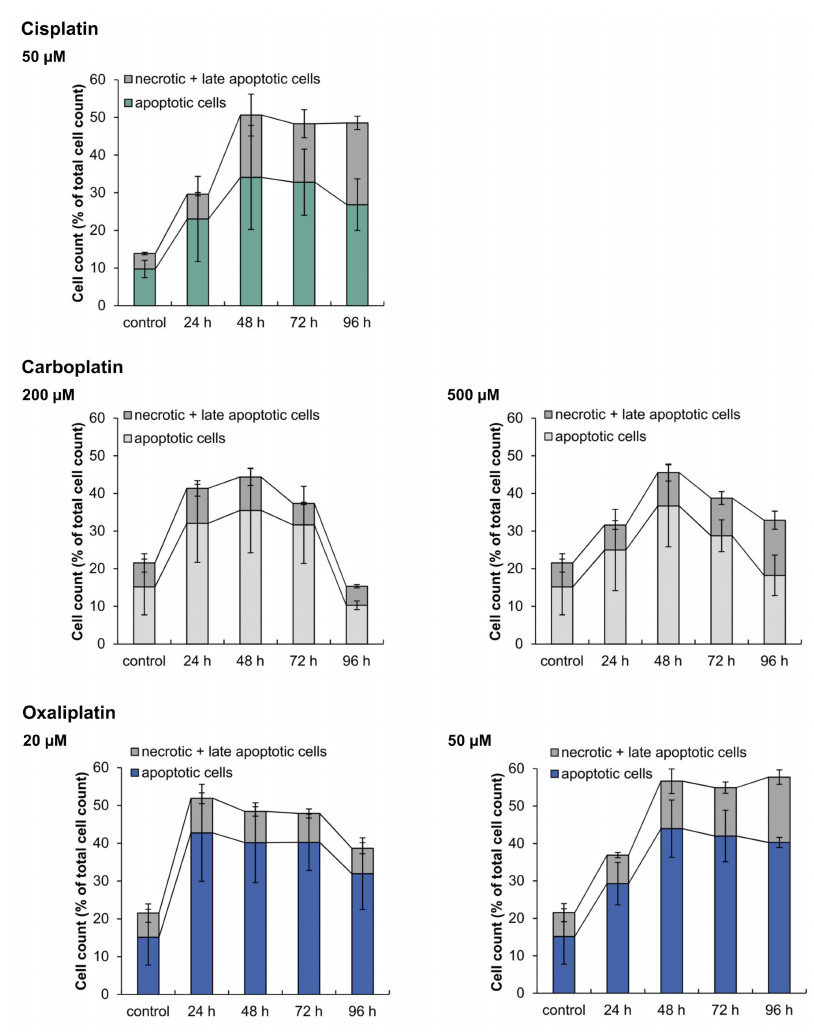
Figure 8. Analysis of apoptotic and necrotic cells after incubation of A498 cells with cisplatin, carboplatin or oxaliplatin. Cells were incubated for 1 h with cisplatin (50 µ M), carboplatin (200, 500 µ M) or oxaliplatin (20, 50 µ M) followed by postcultivation of 24, 48, 72 or 96 h. To distinguish between apoptotic and necrotic + late apoptotic cells, cells were stained with Annexin V-FITC and propidium iodide (PI). Cell cycle distribution was then analyzed by flow cytometry. The mean values are shown of three independent experiments ± standard deviation. The data for cisplatin are taken from